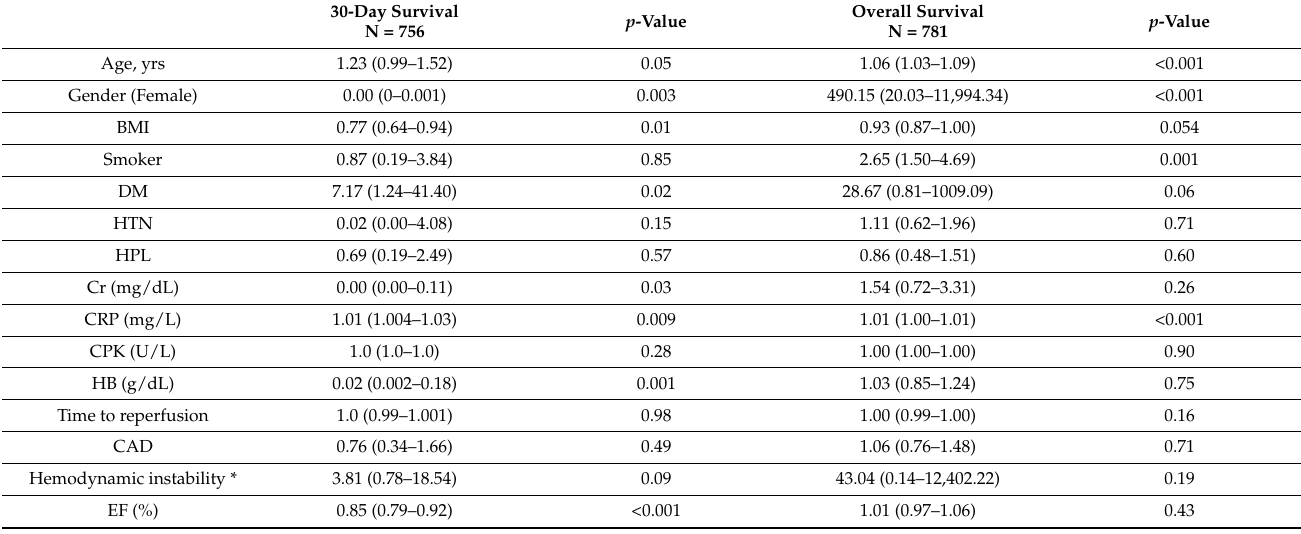
Table 5. Risk factors for